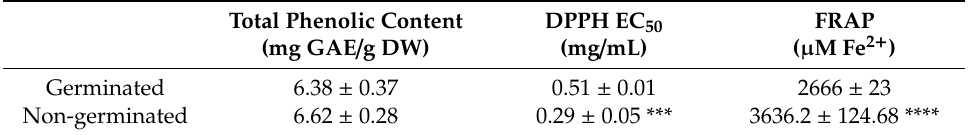
Table 1. Total phenolic content and in vitro antioxidant activities of germinated and non-germinated sorghum flour. Results were expressed as mean ± standard deviation (SD) of three independent determinations. Total Phenolic Content DPPH EC 50 FRAP (mg GAE / g DW) (mg / mL) ( µ M Fe 2 + ) Germinated 6.38 ± 0.37 Non-germinated 6.62 ±